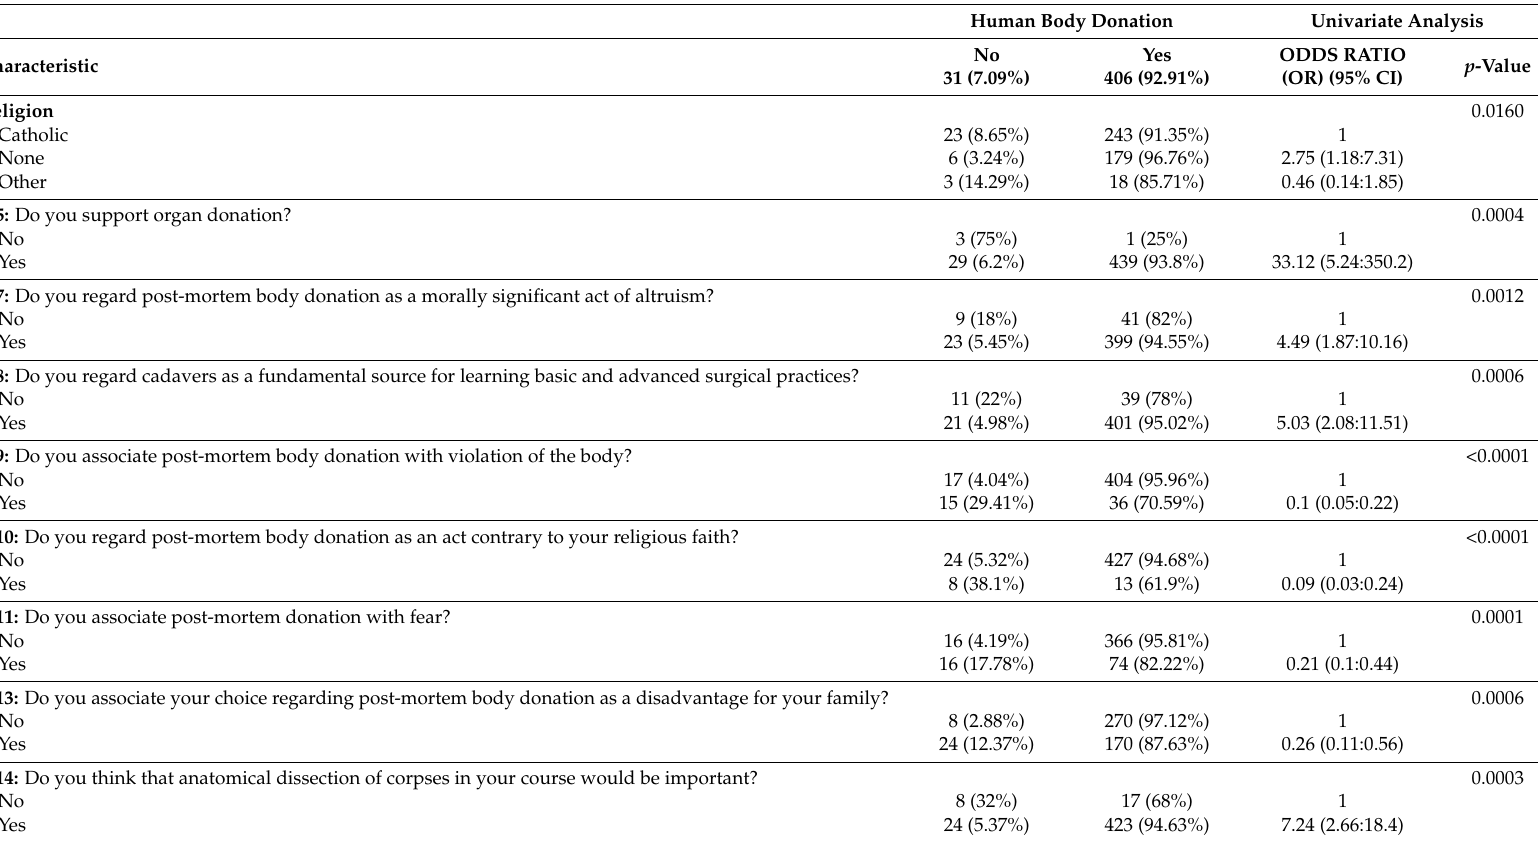
Table 2. Significant results on univariate